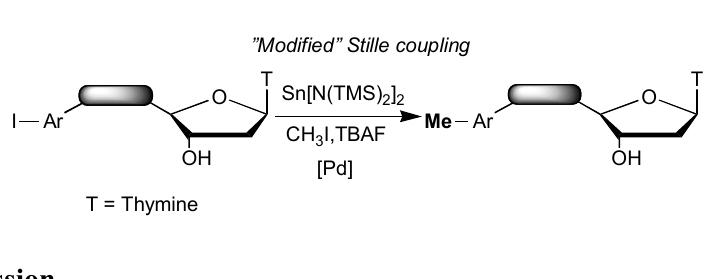
Scheme 1. Methyl transfer reaction.